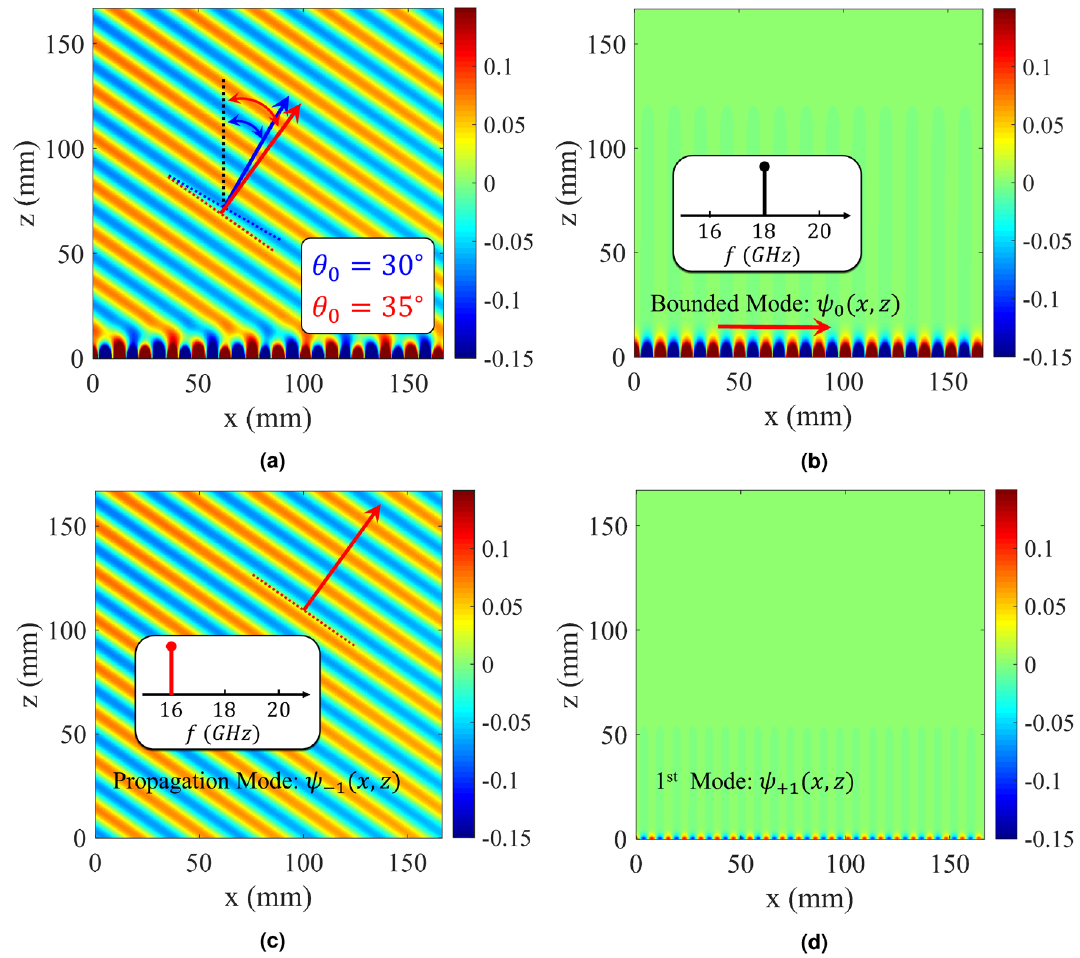
Figure 8. Analytical results of the proposed spationtemporally modulated hologram in transmission mode. ( a ) Total field, ( b ) fundamental mode, ( c ) radiation mode, and ( d ) (+1)-index